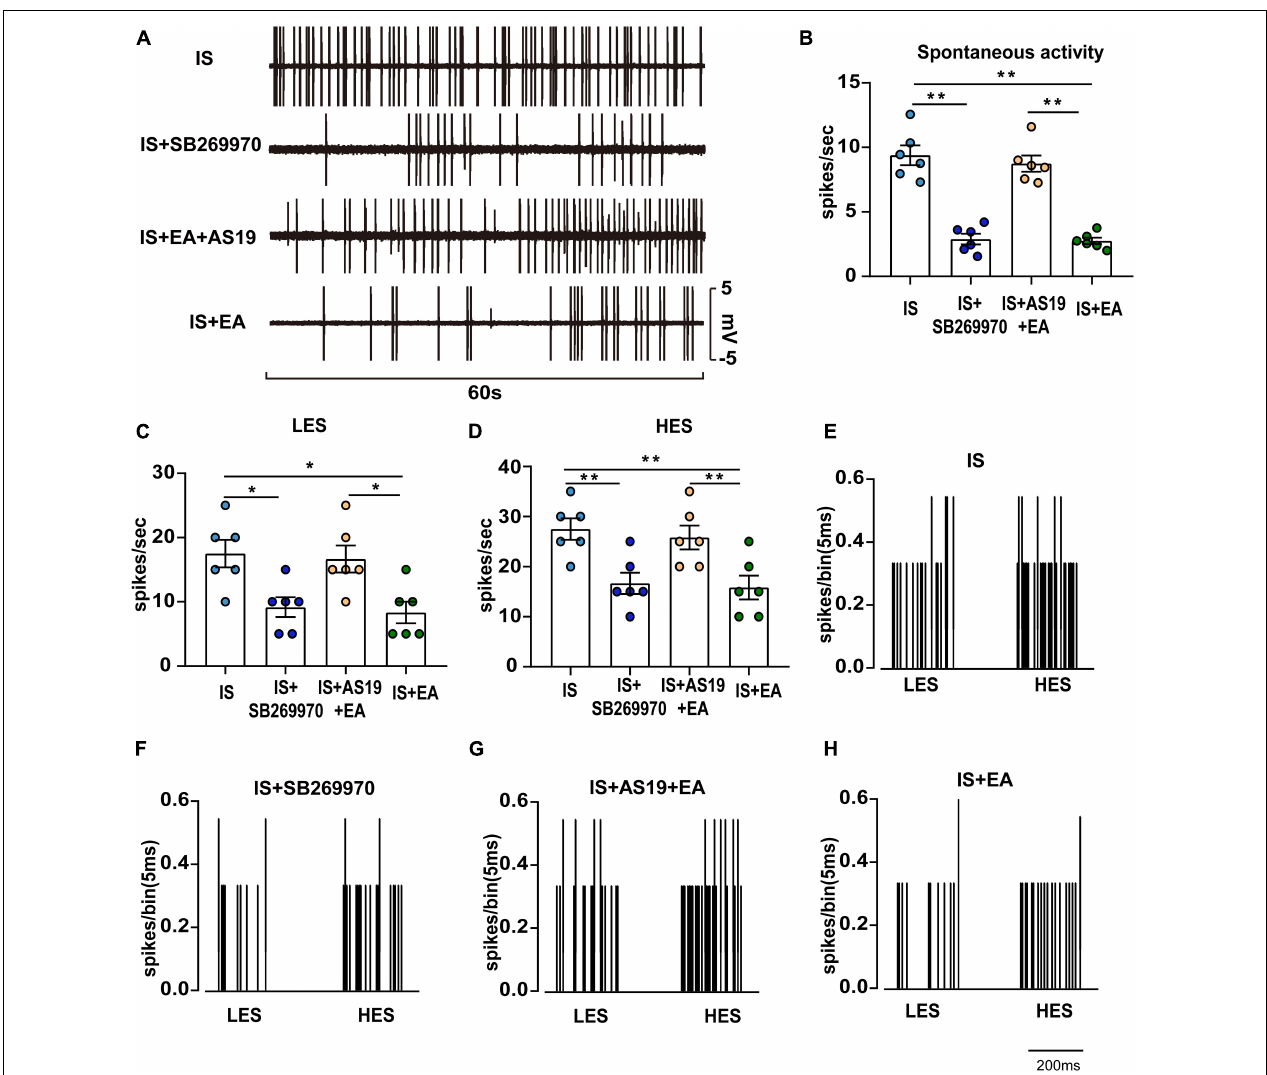
FIGURE 8 | Overview of the electrophysiological recordings and neuronal characteristics among the IS, IS + SB269970, IS + AS19 + EA, and IS + EA groups. (A) Spontaneous activity was recorded for 60 s at 30 min postfinding the activated neurons for stabilization among the indicated groups. Spontaneous activity (B) , LES-evoked responses (C) , and HES-evoked responses (D) of WDR neurons recorded 2 h after the 4th IS in the TCC of none manipulation (IS and IS + SB269970) (E,F) and EA (IS + AS19 + EA and IS + EA) (G,H) rats. When four groups were compared for electrophysiology, a Kruskal-Wallis test was used, and when only two groups were compared, a Mann-Whitney U test was used. Group values are indicated by mean ± SEM. * P < 0.05, ** P < 0.01. Tc, the stimulation intensities required to evoke neuronal activity with a conductive velocity of 0.4–2 m s − 1 , namely about 2 mA. 5-HT 7 R, 5-hydroxytryptamine (5-HT) 7 receptor; LES,